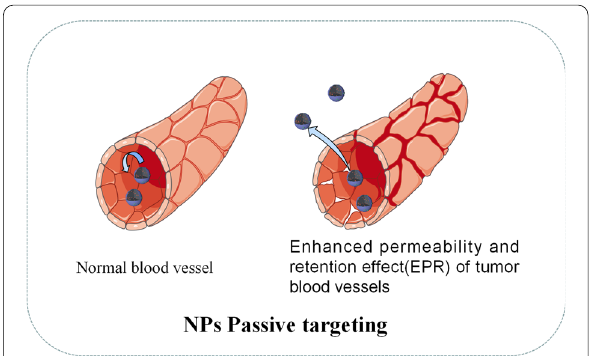
Fig. 3 Diagrammatic illustration of passive targeting of